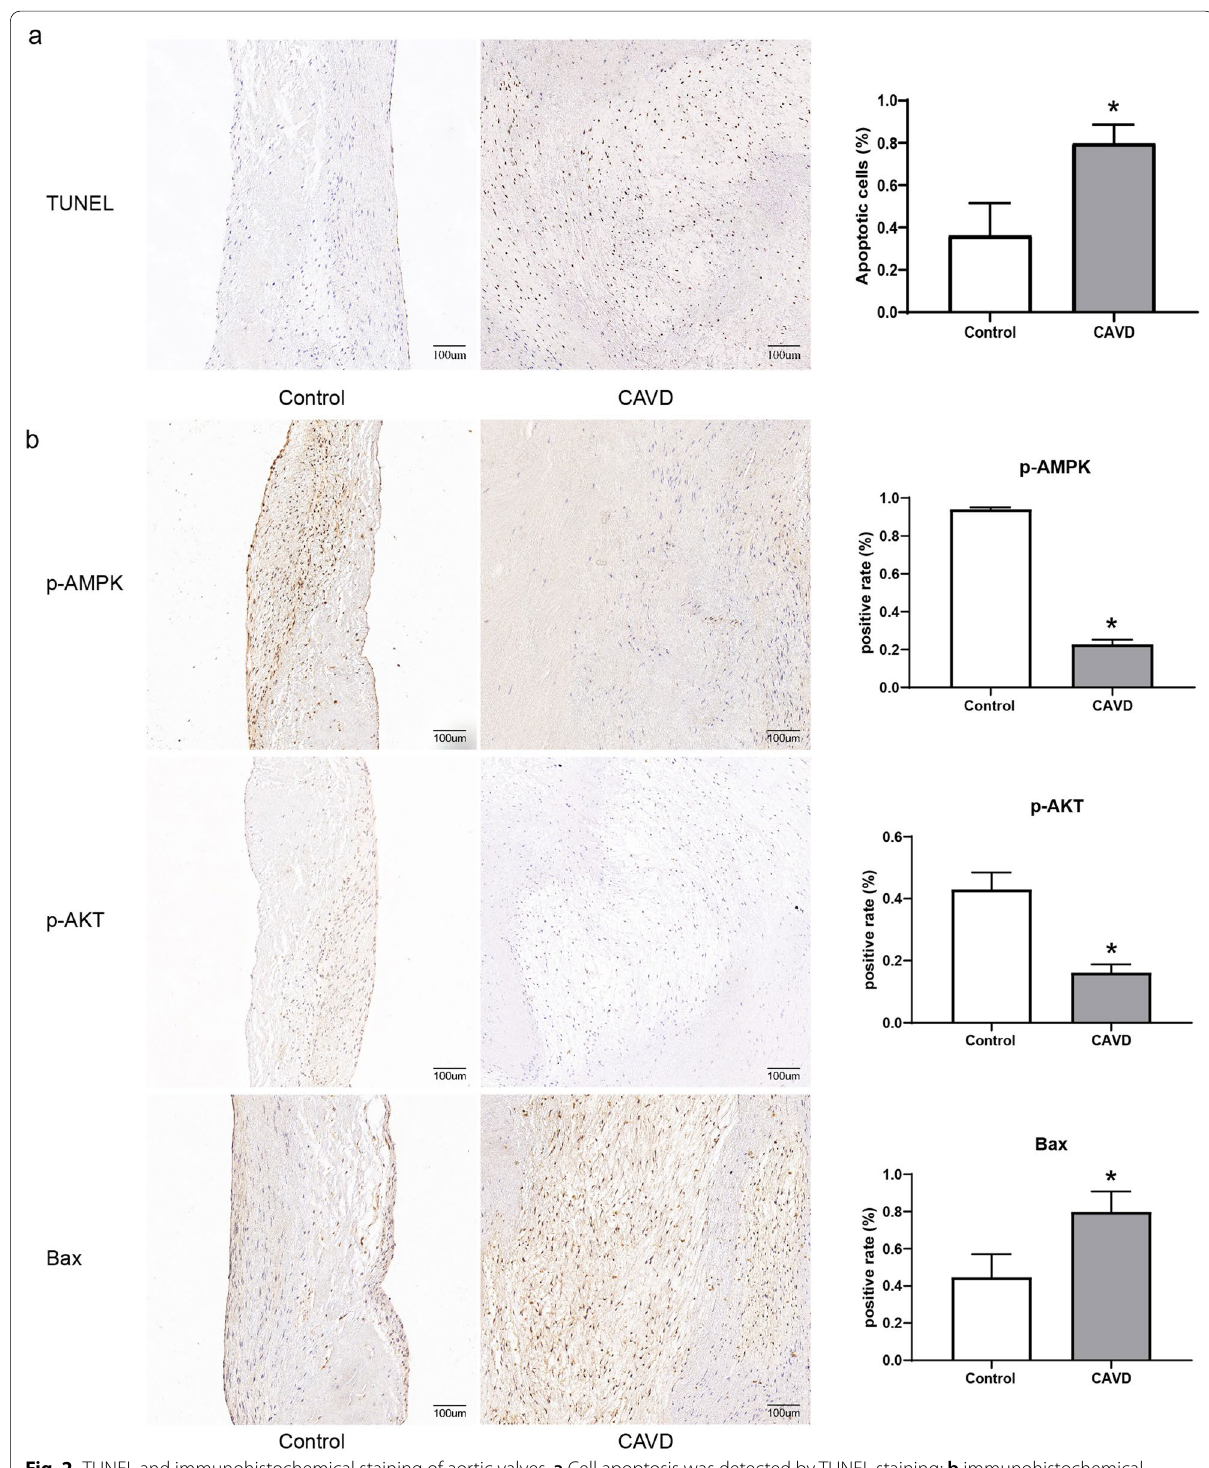
Fig. 2 TUNEL and immunohistochemical staining of aortic valves. a Cell apoptosis was detected by TUNEL staining; b immunohistochemical evaluation of p-AMPK, p-AKT, and Bax expression in control (n in the total number of cells in the sample; Scale bar, 100 μm; CAVD, calcific aortic valve disease; *p < 0.05 versus control group (Student’s